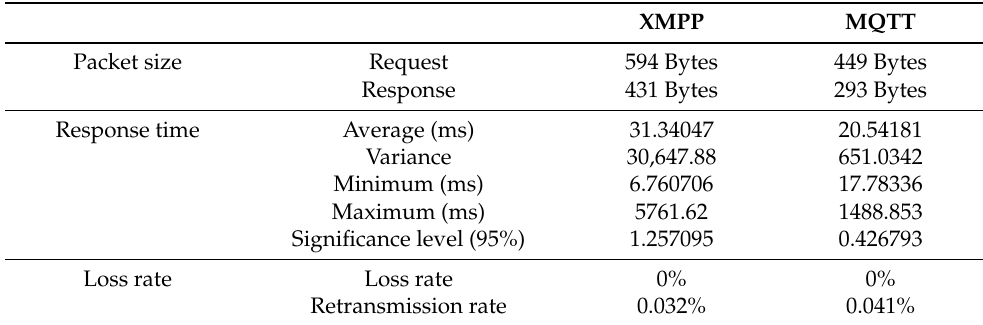
Table 4. Performance comparison of the XMPP and the MQTT protocol.